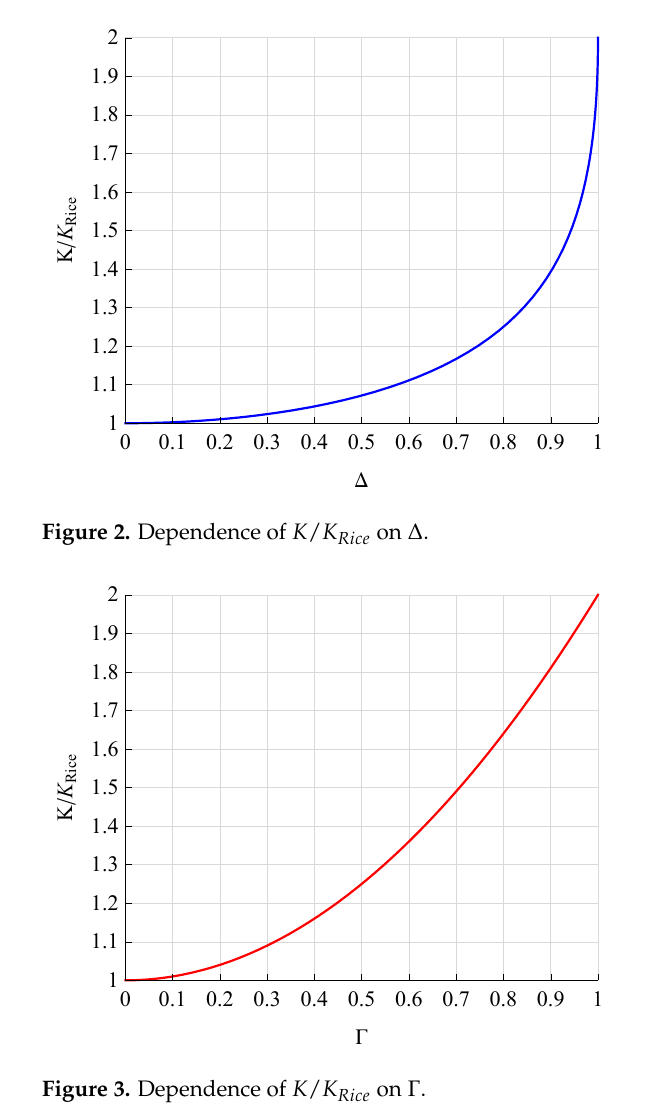
Figure 1. Dependence of ∆ and Γ on V 2 / V 1 .